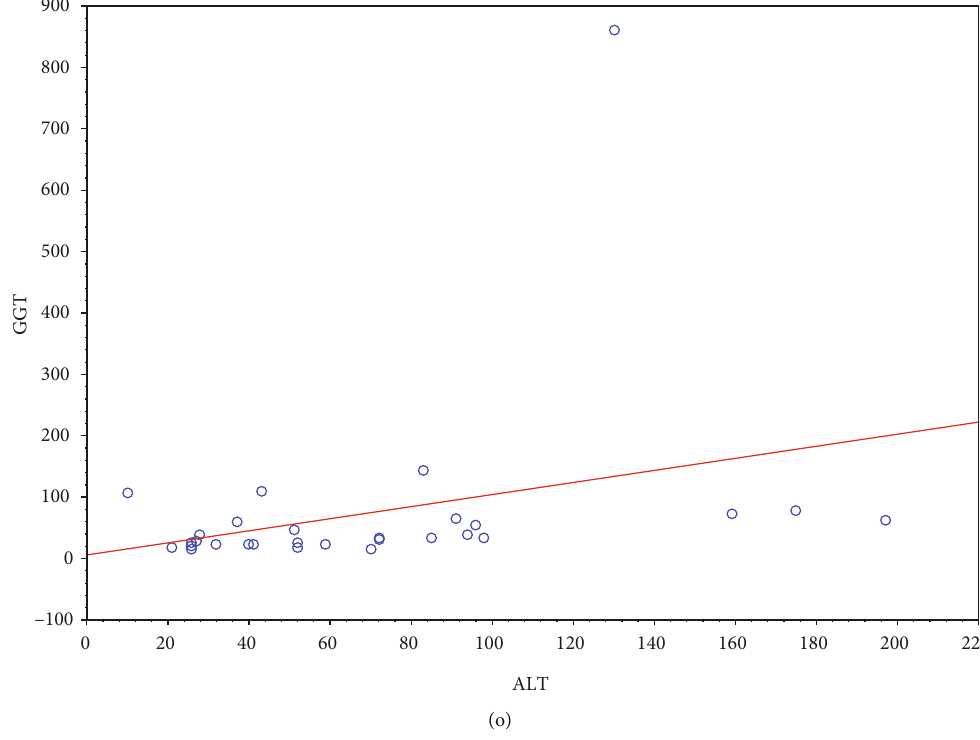
Figure 2: Spearman ’ s correlation analysis between the expression of metalloproteinases, tissue inhibitors, their plasma protein counterparts, and liver injury markers: MMP - 9 and TIMP - 1 (a); MMP - 9 and TIMP - 2 (b); MMP - 9 and MMP - 12 (c); MMP - 2 and TIMP - 1 (d); MMP - 2 and TIMP - 2 (e); TIMP - 1 and TIMP - 2 (f); TIMP - 1 and MMP - 12 (g); TIMP - 2 and MMP - 12 (h); MMP - 12 and IL - 6 (i); MMP - 9 and GGT (j); MMP - 2 and ALT (k); MMP-9 and TIMP-1 (l); MMP-9 and MMP-9/TIMP-1 ratio (m); ALT and ASP (n); ALT and GGT (o). Table 3: Plasma levels of metalloproteinases and their tissue inhibitors as well as cytokines and adipokines in the children with NAFLD and control